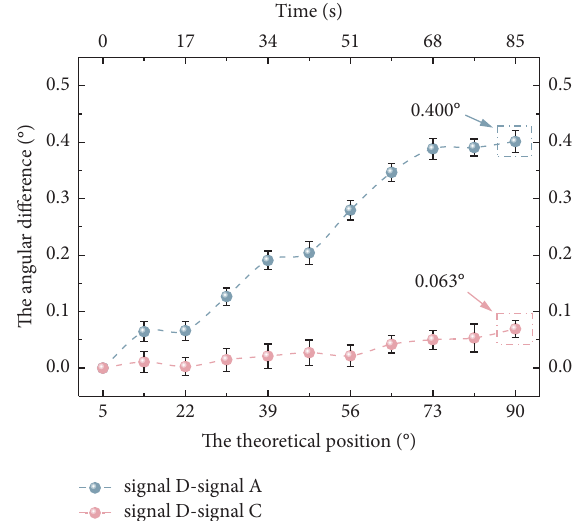
Figure 5: Te angle diference of the single-motor drive (5 ° ∼ 90 ° ).